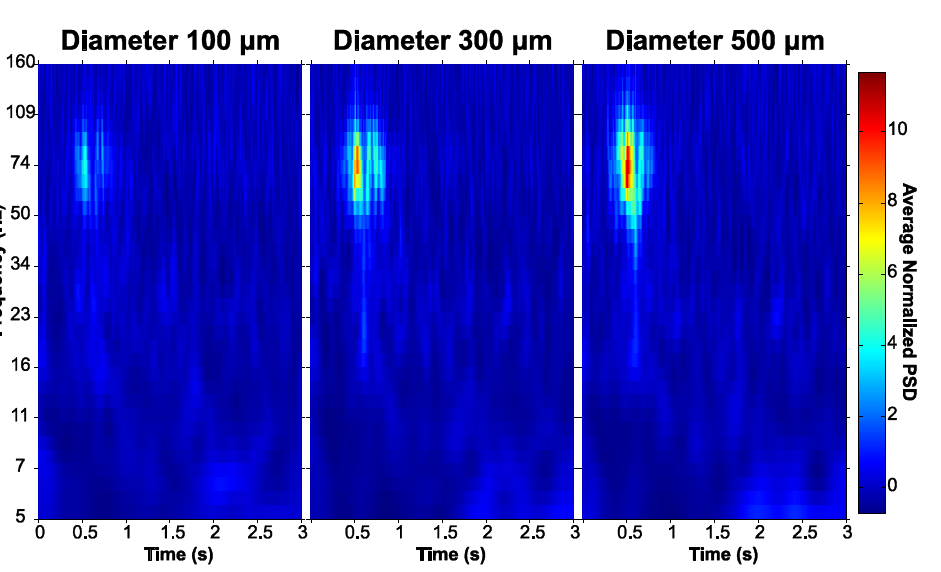
Figure 16. Time-frequency plots of normalized PSD for three neighbouring electrodes of different sizes situated in the middle of the array layout (red circles in the right image of Figure